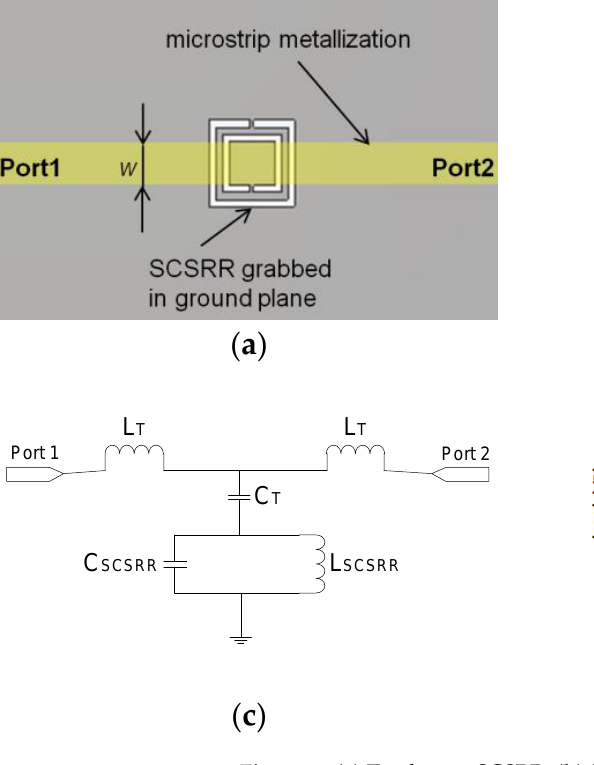
Figure 1. ( a ) Top layout SCSRR. ( b ) SCSRR main dimensions. ( c ) Equivalent circuit model for SCSRR. ( d ) Simulated S21 (solid black line) and simulated S21 for equivalent circuit model (dash-dotted line). The equivalent circuit for the SCSRR contains the same components used to model the CSRR [32]. The inductance L SCSRR and capacitance C SCSRR are calculated by considering the perimeter of the square, the width of the SCSRR ( c ) and the separation between rings ( d ), and by applying the same electromagnetic calculations provided in [32]. The microstrip line is characterized by its T-model [36], with its lumped components L T and C T , where L T and C T are the per-section inductance and capacitance of the microstrip line. The circuit